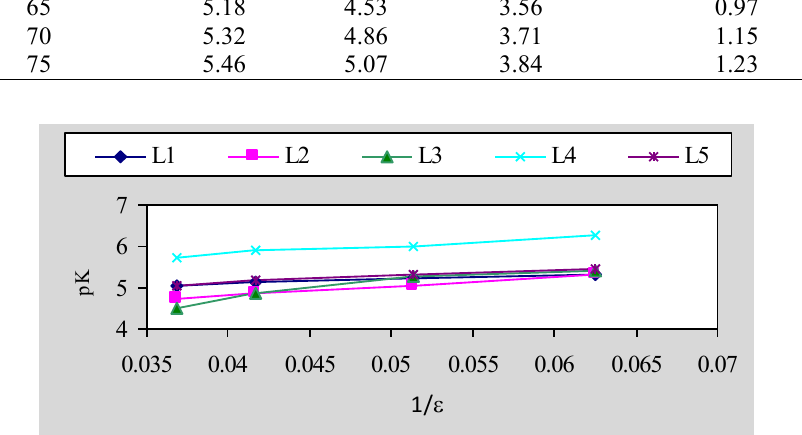
Figure 3. Variation of pK with 1/ 